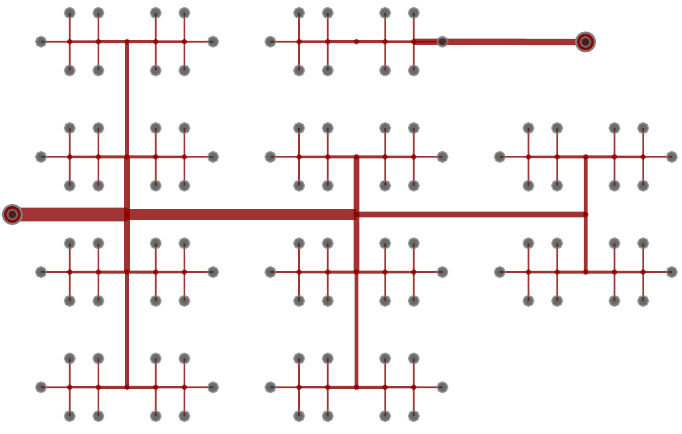
Figure A5. Generic separation scenario 1.